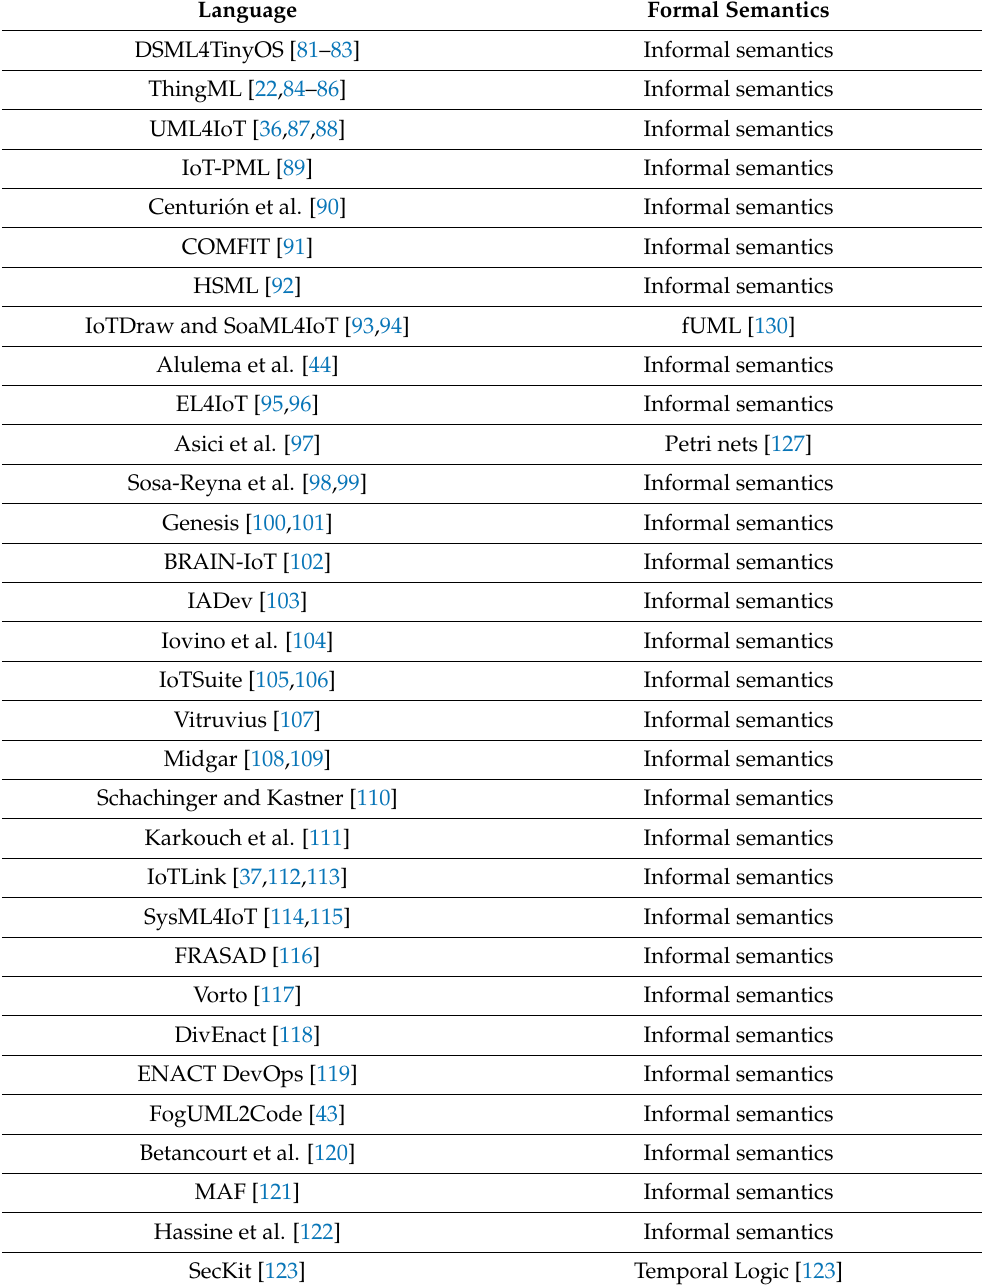
Table 3. The modeling languages for IoT that support informal semantics or formal semantics